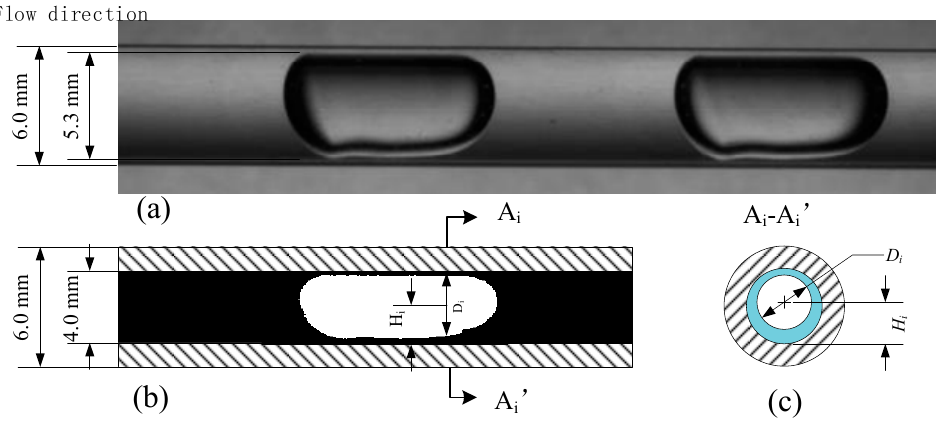
Figure 9. ( a ) Original image of the slug flow; ( b ) binary image; ( c ) cross-section.